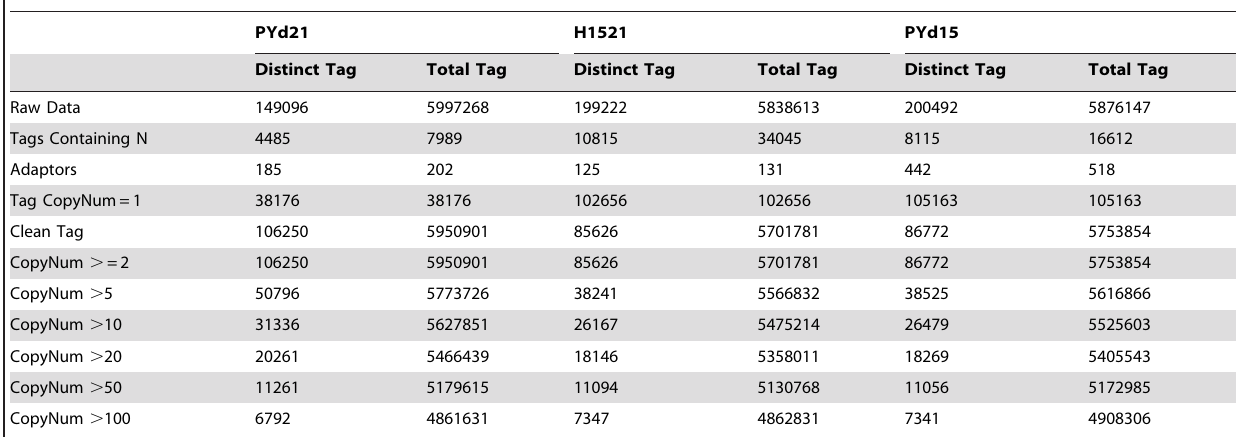
Table 2. Major characteristics of DGE libraries.